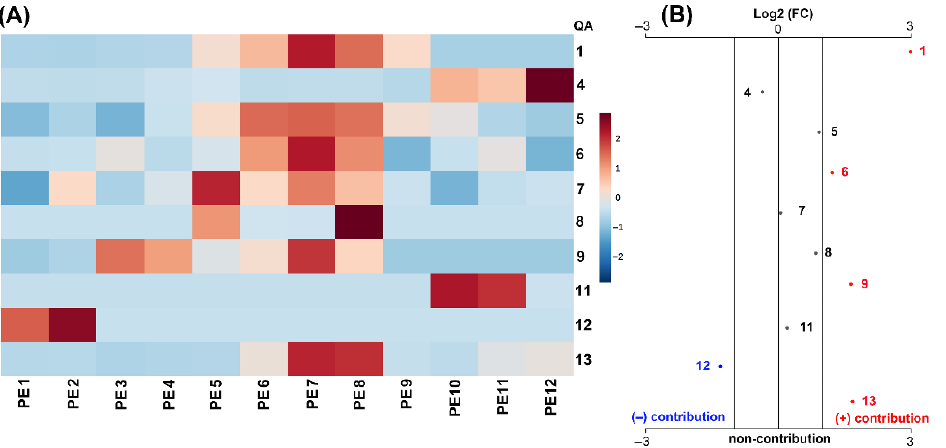
Figure 7. Comparison of quinolizidine alkaloid (QA) contents (mg/g fresh leaves) of quinolizidine-rich extracts (QREs) obtained after twelve pruning events on L. polyphyllus . ( A ) Heatmap visualization of the normalized content distribution (unit of variance scaling) of quantified QAs of each resulting QRE. Autoscaled QA contents are related to the color scale: 2 = high content; − 2 = low content. ( B ) Unpaired fold-change (FC) analysis plot for selecting important QAs with threshold 2, by integrating the chemical (QA contents) and biological (mycelial growth inhibition) data. Antifungal activity was used as a categorical variable, subdividing the antifungal activity of QREs into two datasets: more active (>90% inhibition) and less active (<85% inhibition), according to the Tukey test, to supervise the QA selection among QREs. According to the antifungal activity, positive and negative contributions to the FC-based QA selection are depicted as red and blue numbers and dots.